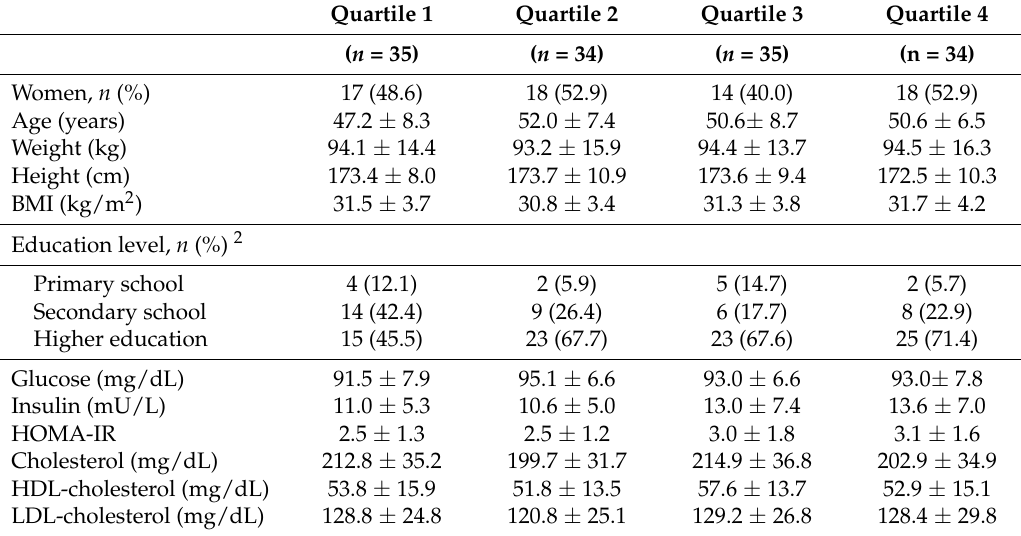
Table 1. Baseline characteristics of the study cohort by weight loss quartiles (138) 1